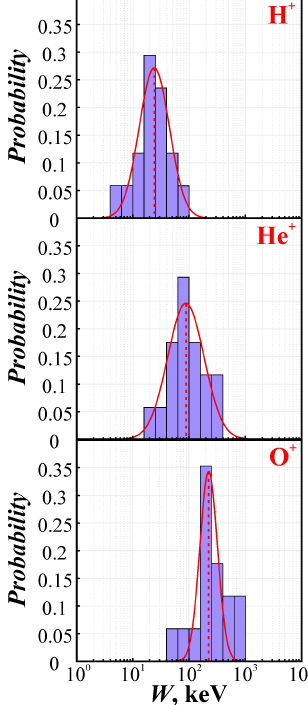
Figure 7. Histograms of probability to observe the given values of H + , He + and O + ion energy gain in the course of nonadiabatic acceleration at the onset-related DF (see explanation in the